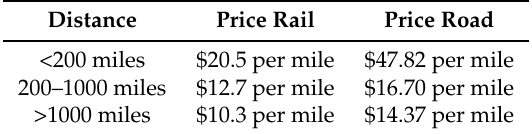
Table 2. Transportation cost per cask for rail and road